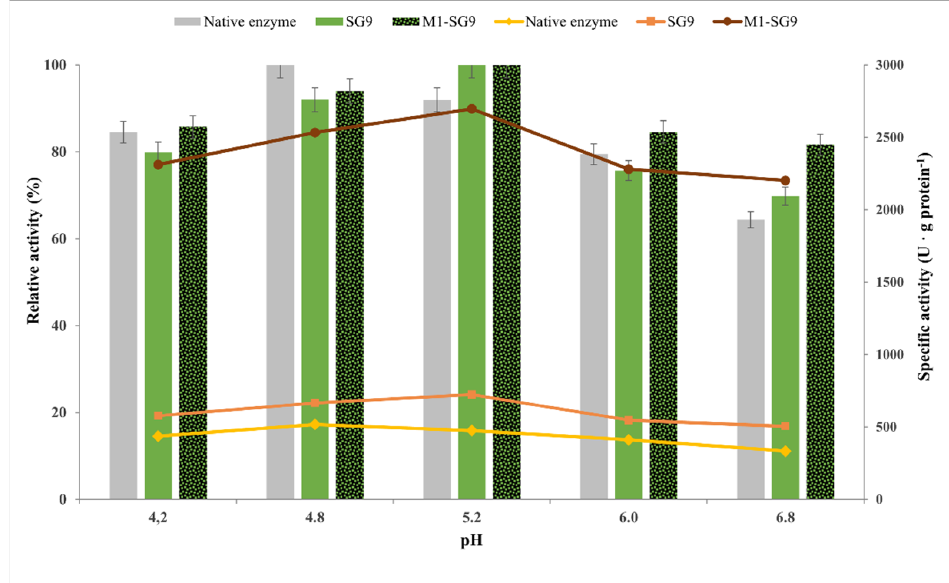
Figure 12. Influence of pH on the catalytic efficiency of native and immobilized Cellic CTec2 cellu- lase by entrapment in sol–gel (SG9) and magnetic sol–gel (M1-SG9) with VTMOS:PhTMOS:TMOS (0.4:1.6:1) in the hydrolysis of CMC at 30 min reaction time and 50 °C.